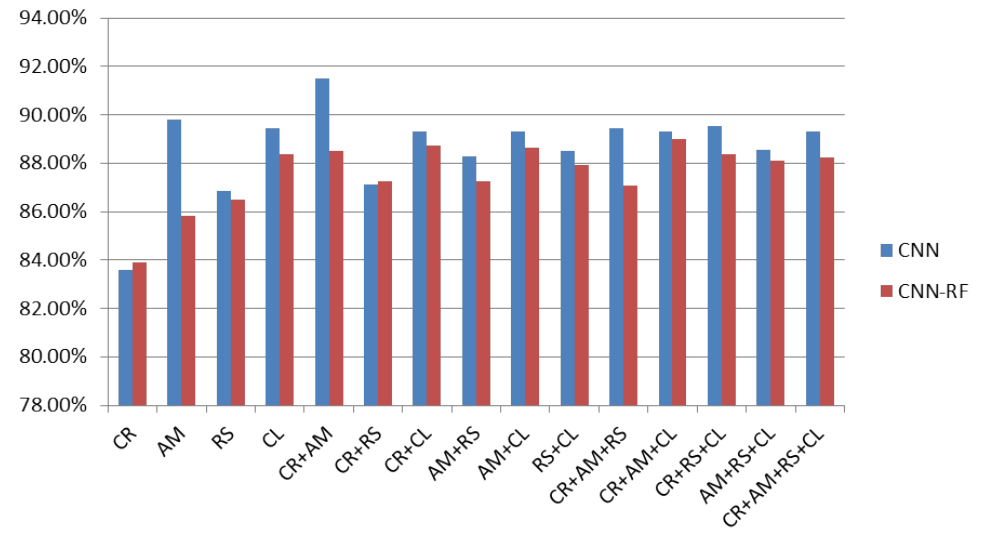
Figure 8. Fusion of CNN-RF as substitute of CNN softmax